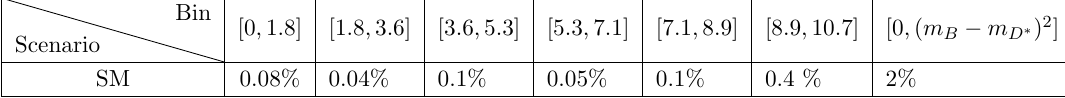
i 0 with T i 0 i.e. the T